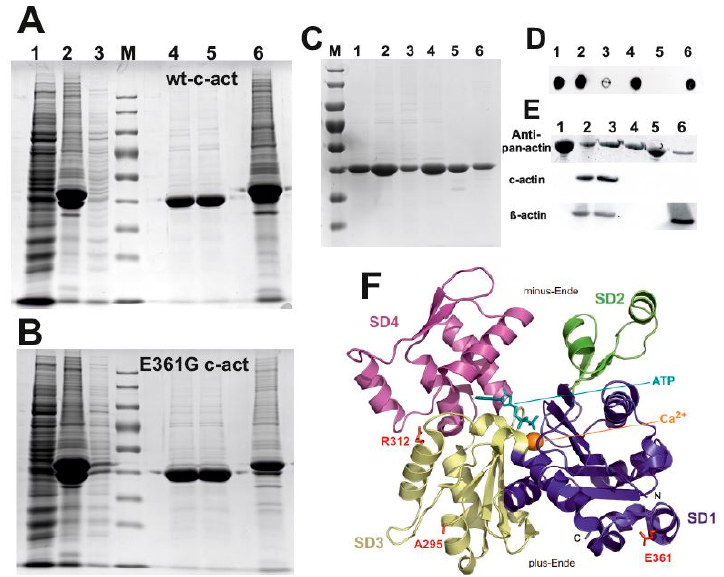
Figure 1. Purification of cardiac actins after expression by the baculovirus/Sf21 system. ( A , B ) SDS- PAGE of purification steps of ( A ) wt c-actin and ( B ) the p.E361G mutant c-actin. Lanes: (1) Sf21 cell homogenate, (2) supernatant after mixture with His-tagged G4-6, and (3) pellet after centrifugation, (M) pre-stained marker proteins, lanes (4,5) purified c-actins after elution of Ni-NTA agarose with EGTA (for details see text), and lane (6) Ni-NTA agarose with His-tagged G4-6 still bound. ( C ) SDS- PAGE of the purified cardiac actin variants used in this study. Lanes: (1) wt recombinant; (2) p.A295S; (3) p.R312K; (4) p.E361G; (5) skeletal muscle actin; and (6) bovine cardiac actin. Actins shown in lanes (5) and (6) were conventionally prepared from acetone powders. ( D ) Dot immunoblots of the actins shown in the same sequence as in ( C ) using the anti-cardiac actin monoclonal antibody. Note that the p.R312K mutant is only weakly and skeletal muscle actin is not stained by anti-c-actin mAB. ( E ) (Upper row) SDS-PAGE of the following actins: Lanes: (1) skeletal muscle actin; (2) wt cardiac actin (recombinant); (3) bovine cardiac actin; (4) cytoplasmic β -actin; (5) actin purified from Acanthameba castellani ; and (6) cytoplasmic β -actin. (Middle row ) Western blots immunostained with anti-cardiac actin mAB. ( Lower row) Western blots stained with anti-cytoplasmic β -actin. ( F ) 3D structural model of G-actin derived from the skeletal muscle actin:DNase I complex [25] indicating the positions of the mutated residues of the c-actin mutants investigated. In addition, subdomains (SD) as well as the position of ATP and Ca 2+ are indicated.